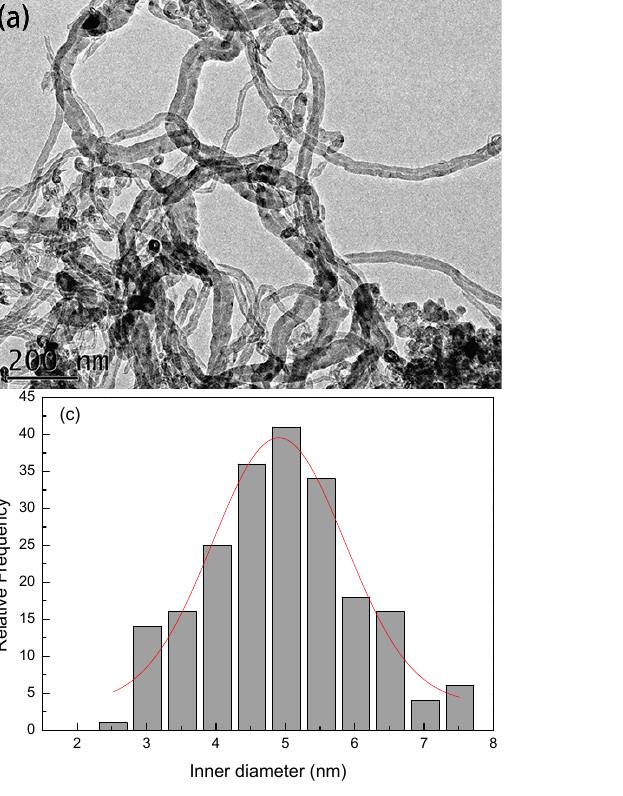
Figure 1. TEM images of ( a ) MWCNTs, ( b ) MWCNT-CH 2 OCOC 12 H 23 O 3 . The inner-diameter-distribution curve of ( c ) MWCNTs, ( d ) MWCNT-CH 2 OCOC 12 H 23 O 3 .